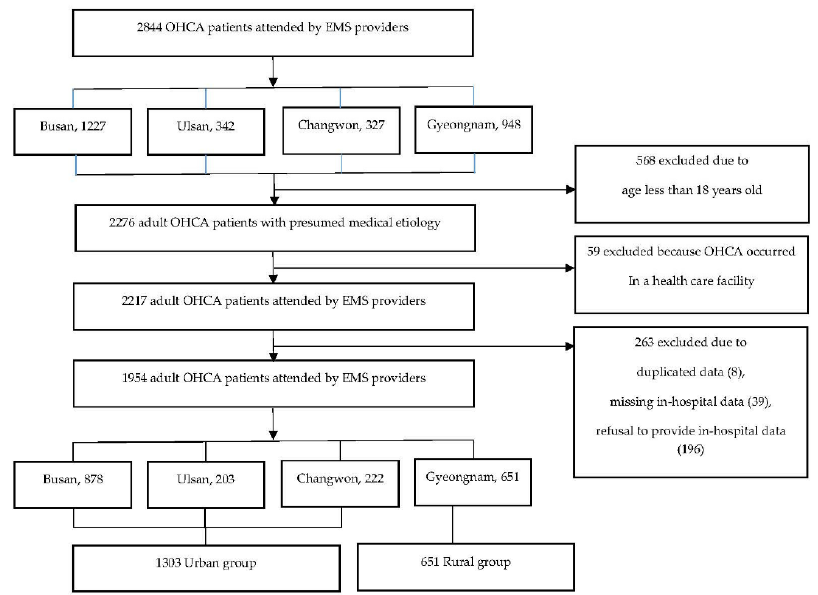
Figure 1. Flowchart of the study population.